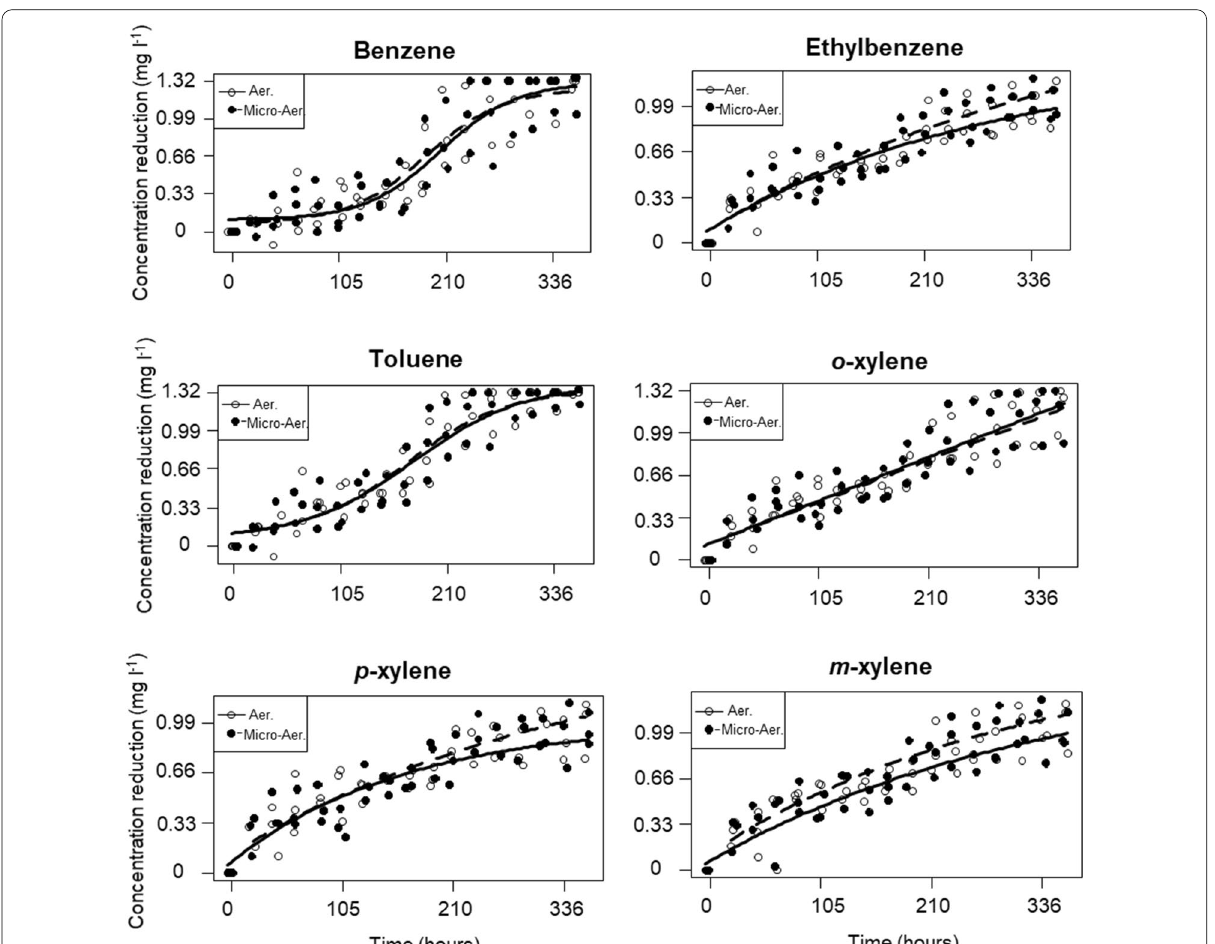
Fig. 3 Fitted models of the degradation processes of the six BTEX compounds in the aerobic and micro-aerobic systems. Parameters of the models are displayed in Additional file 1: Table